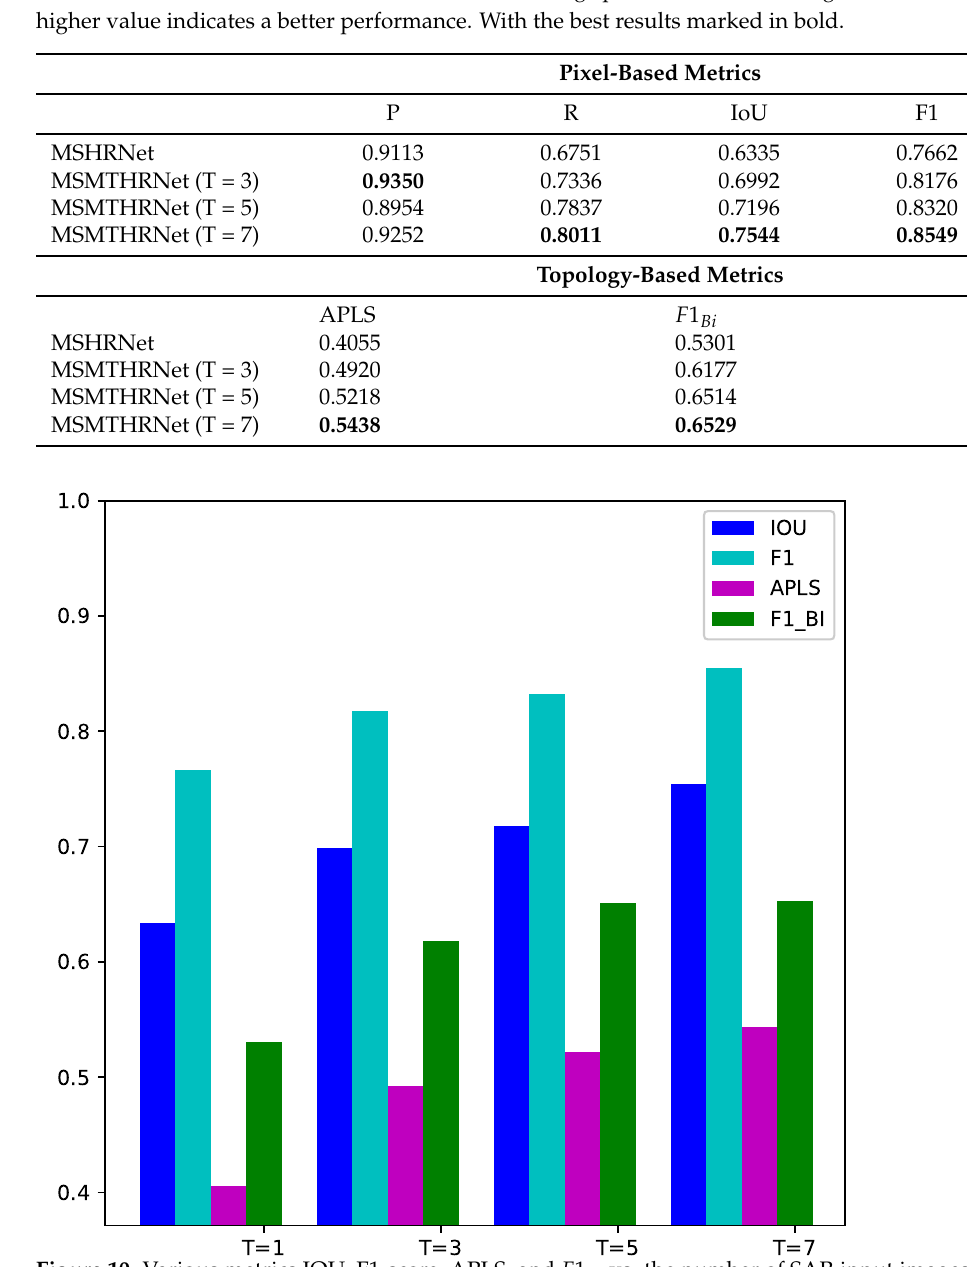
Figure 10. Various metrics IOU, F1-score, APLS, and F 1 Bi vs. the number of SAR input